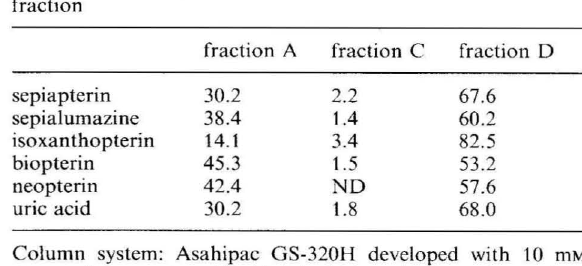
Table 5. Percentage of pteridines and uric acid in each cell fraction fraction A fraction C fraction D sepiapterin